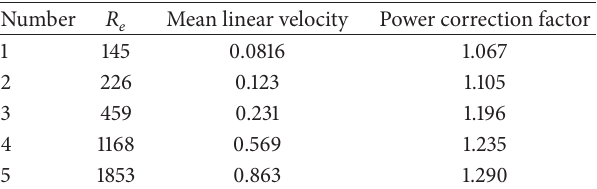
Table 3: The result of mean linear velocity.